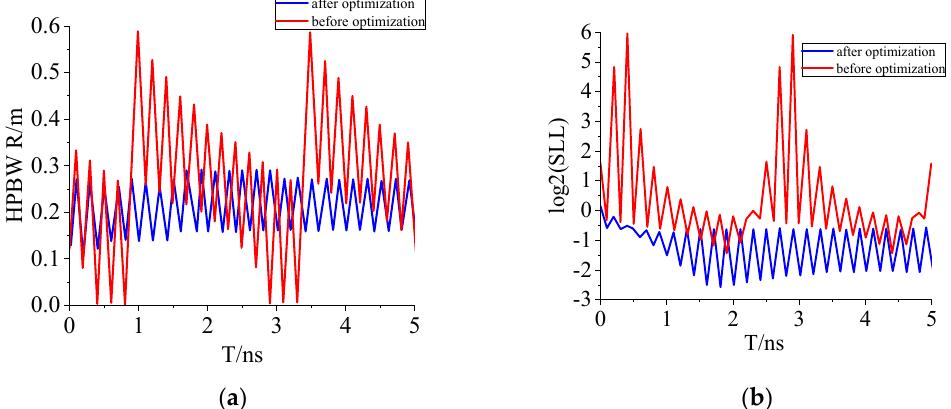
Figure 3. ( a ) Half-power beam-width with time and ( b ) sidelobe changes with time.